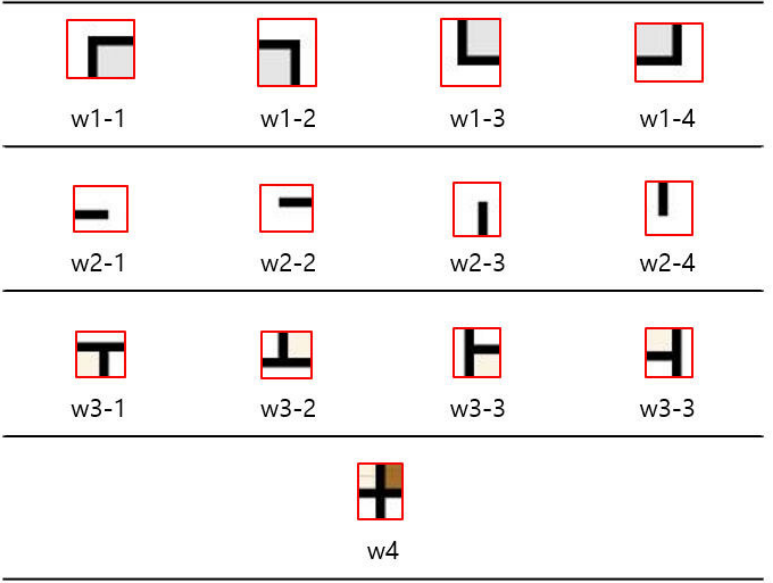
Figure 4. Wall junction types.